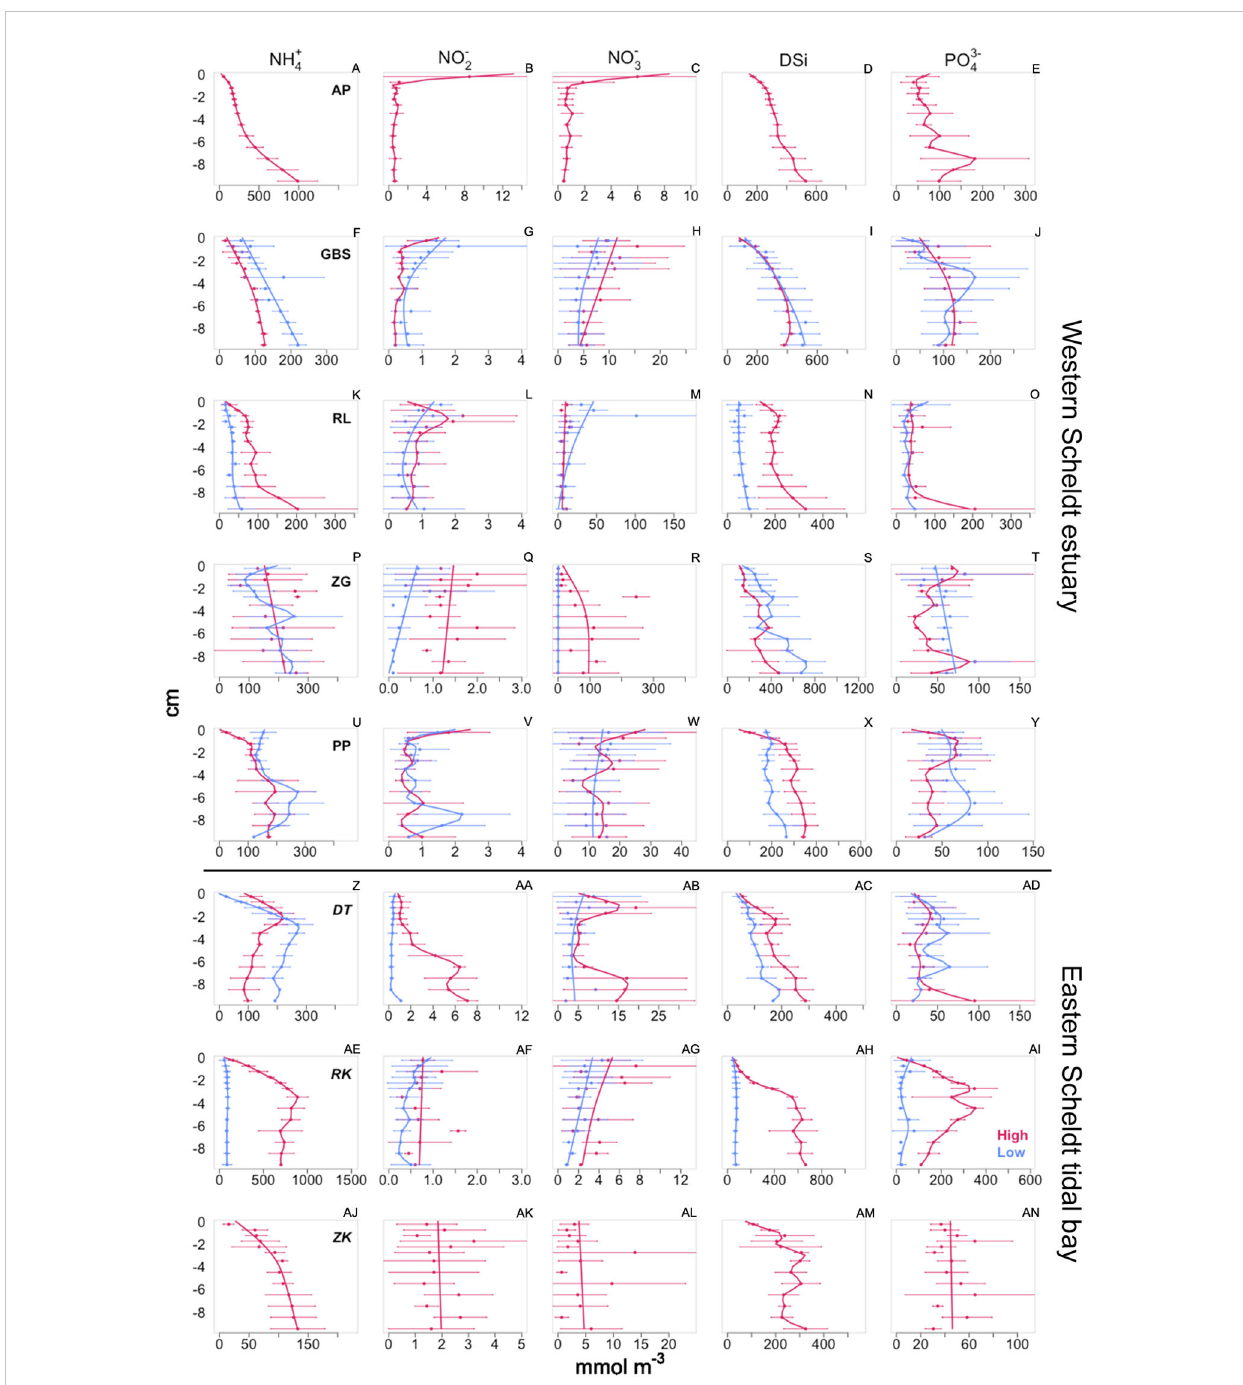
FIGURE 3 Pore water pro fi les from the high (red) and low (blue) tidal zone from the Western (A – Y) and Eastern Scheldt (W – AN) sites. Dots and horizontal lines represent mean ± standard deviation of pore water concentration. Vertical line is a smoothed spline. Western Scheldt site are ordered from upstream to downstream. Notice differences in x axis